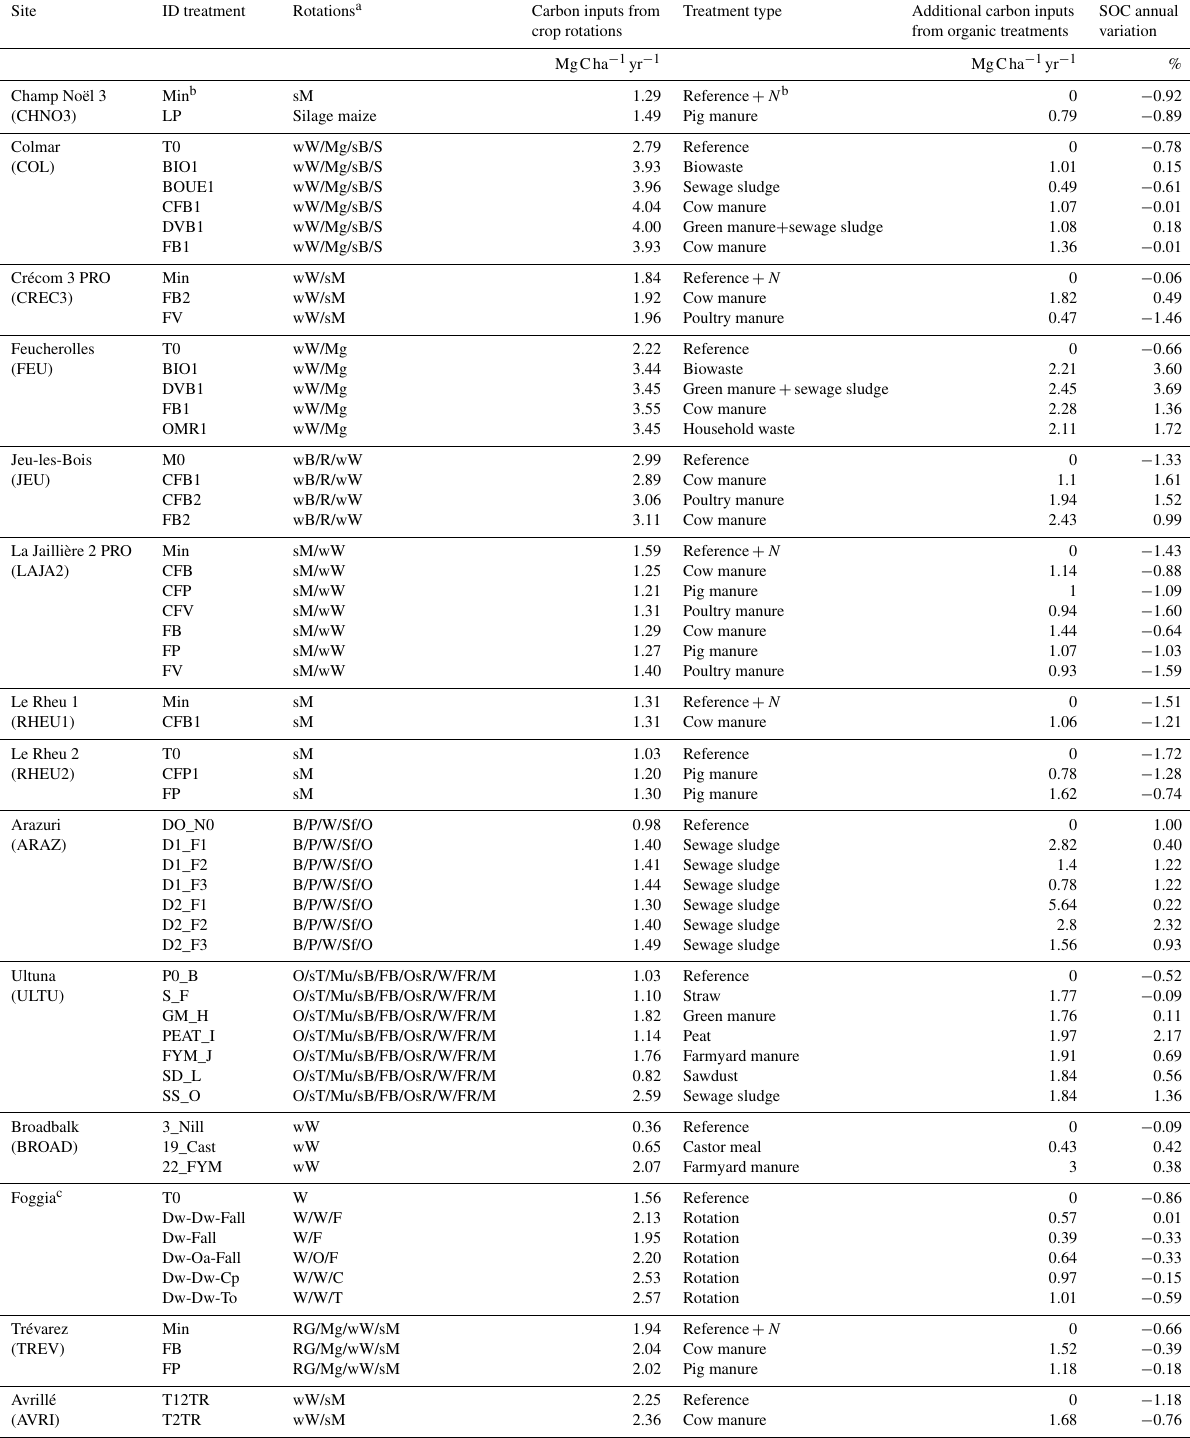
Table 1. Summary of the agricultural experiments included in the study: crop rotations grown at site, amount of carbon inputs (MgCha − 1 yr − 1 ) estimated from crop yields as in Bolinder et al. (2007), type of treatments, amount of additional organic carbon from organic treatments (MgCha − 1 yr − 1 ) and mean annual SOC stock variation